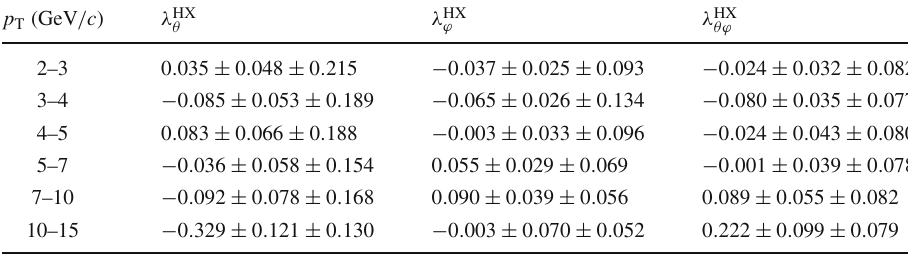
Theerrorbarsrepresentthetotaluncertainties.Leftandrightplotsshow resultsintheCollins-Soperandhelicityframes, respectively,for λ θ (top plots), λ ϕ (middle plots) and λ θϕ (bottom plots)